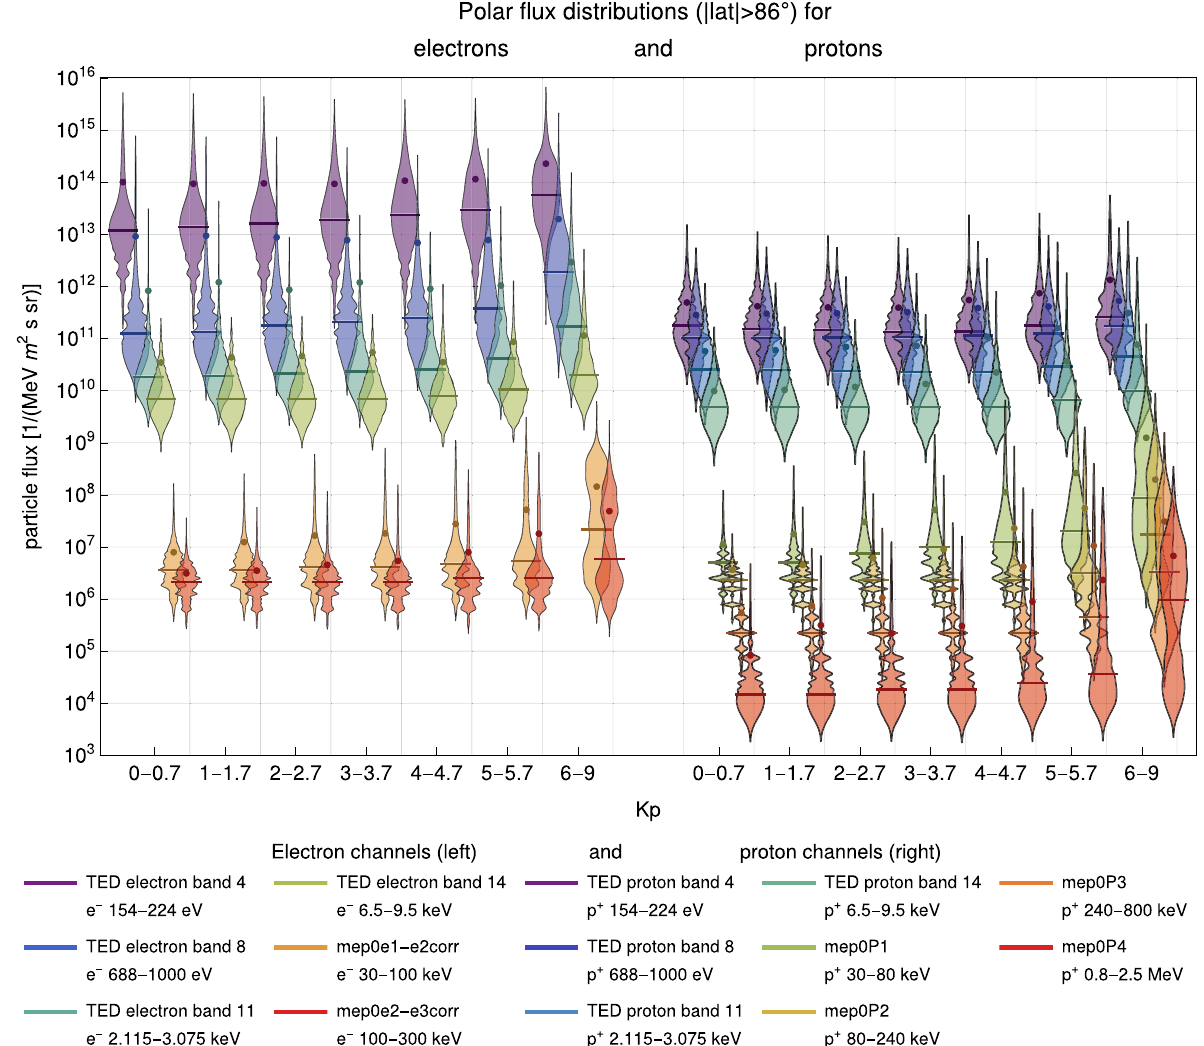
Figure 3. The fi gure shows the central polar cap fl ux distributions ( (cid:5) 86 (cid:1) north and south). The median is indicated by a horizontal line, the dots represent the mean of the respective